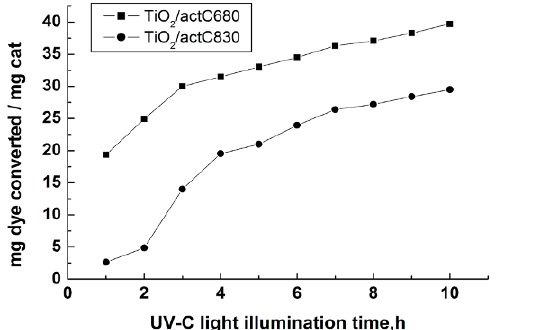
Figure 7. Comparison of the photocatalytic degradation activities of the two composite samples TiO /AC, prepared at 680 o C 2 and at 830 o C under illumination UV-C (monochromatic λ =253.7 nm) light.